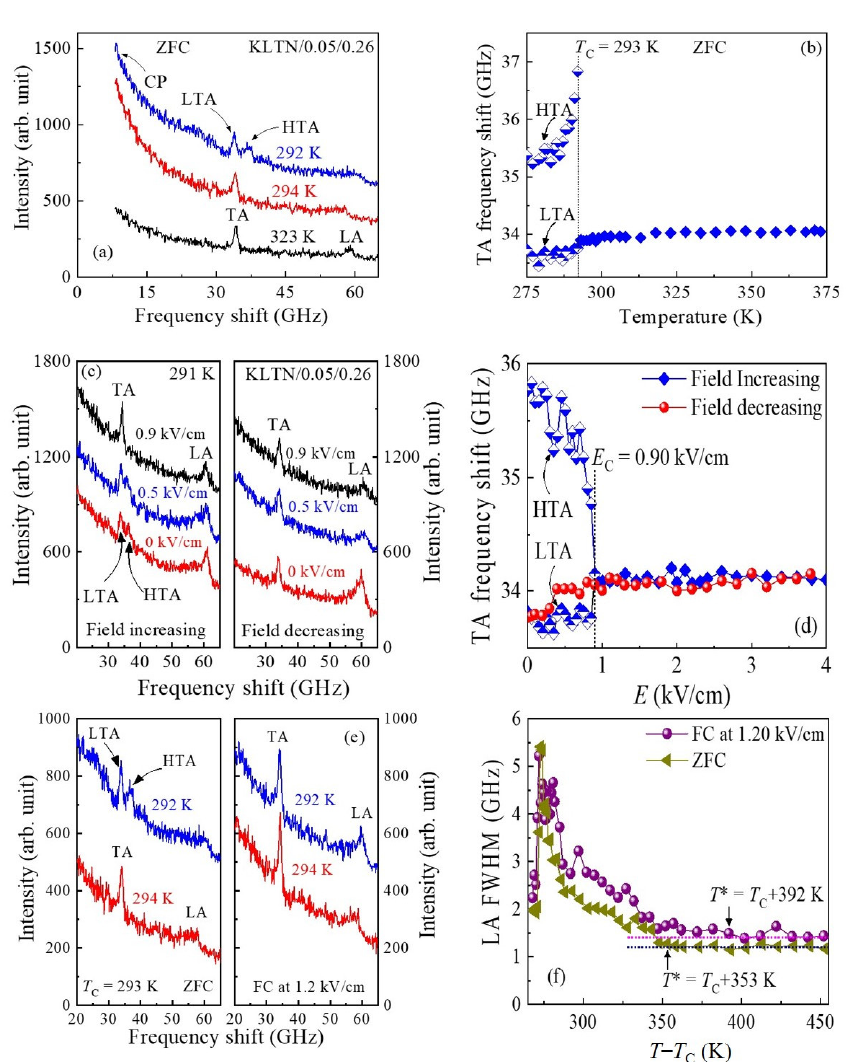
Figure 10. ( a ) Brillouin scattering spectra of the KLTN/0.05/0.26 single crystal at some selected temperatures measured at zero field cooling (ZFC). ( b ) The temperature dependence of the frequency shift of the TA mode of the KLTN/0.05/0.26 single crystal. ( c ) The Brillouin scattering spectra of the KLTN/0.05/0.26 crystal at some selected electric fields measured in the ferroelectric phase under a constant temperature of 291 K, where the electric field was applied along the [100] direction. ( d ) The frequency shift of the TA mode observed in the ferroelectric phase as a function of electric fields. ( e ) The typical Brillouin spectra of the KLTN/0.05/0.26 crystal at some selected temperatures measured under ZFC and field cooling (FC) at 1.20 kV/cm. ( f ) The temperature dependence of the FWHM of the LA mode observed under ZFC and FC process [113].